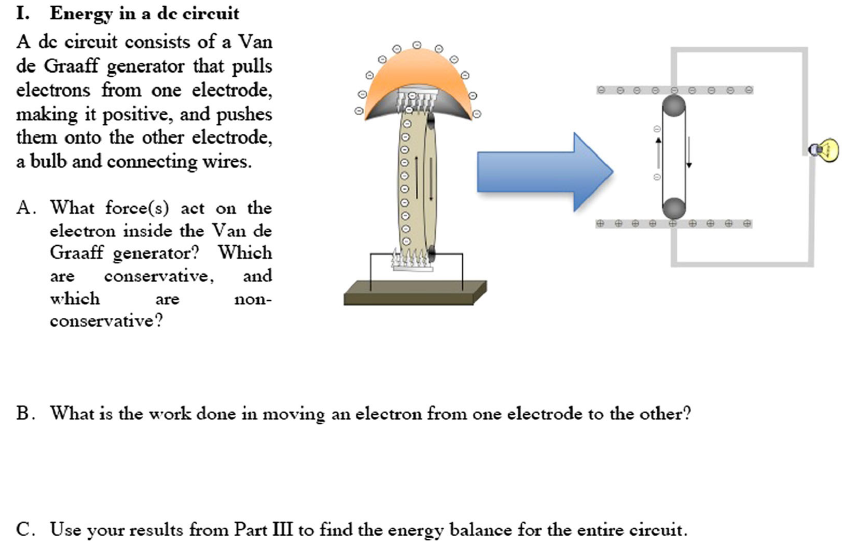
FIG. 2. Activity A2.1 designed to help students to understand the cause of the movement of charges into the battery and the concept of emf in dc